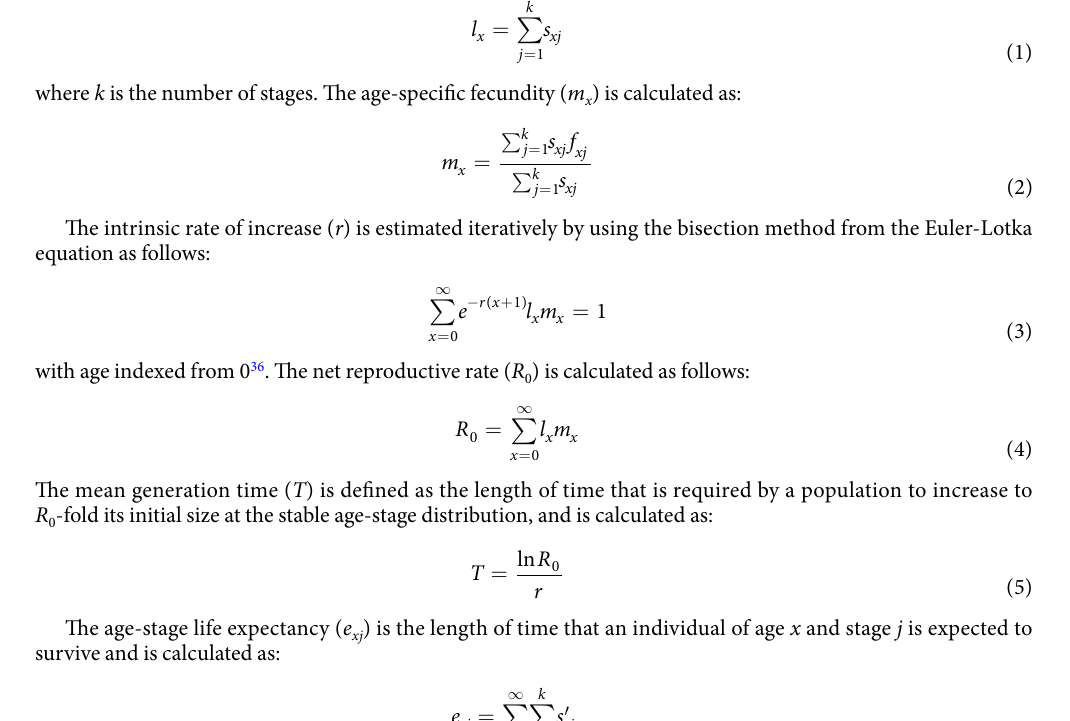
The age-stage life expectancy ( e xj ) is the length of time that an individual of age x and stage j is expected to survive and is calculated as: